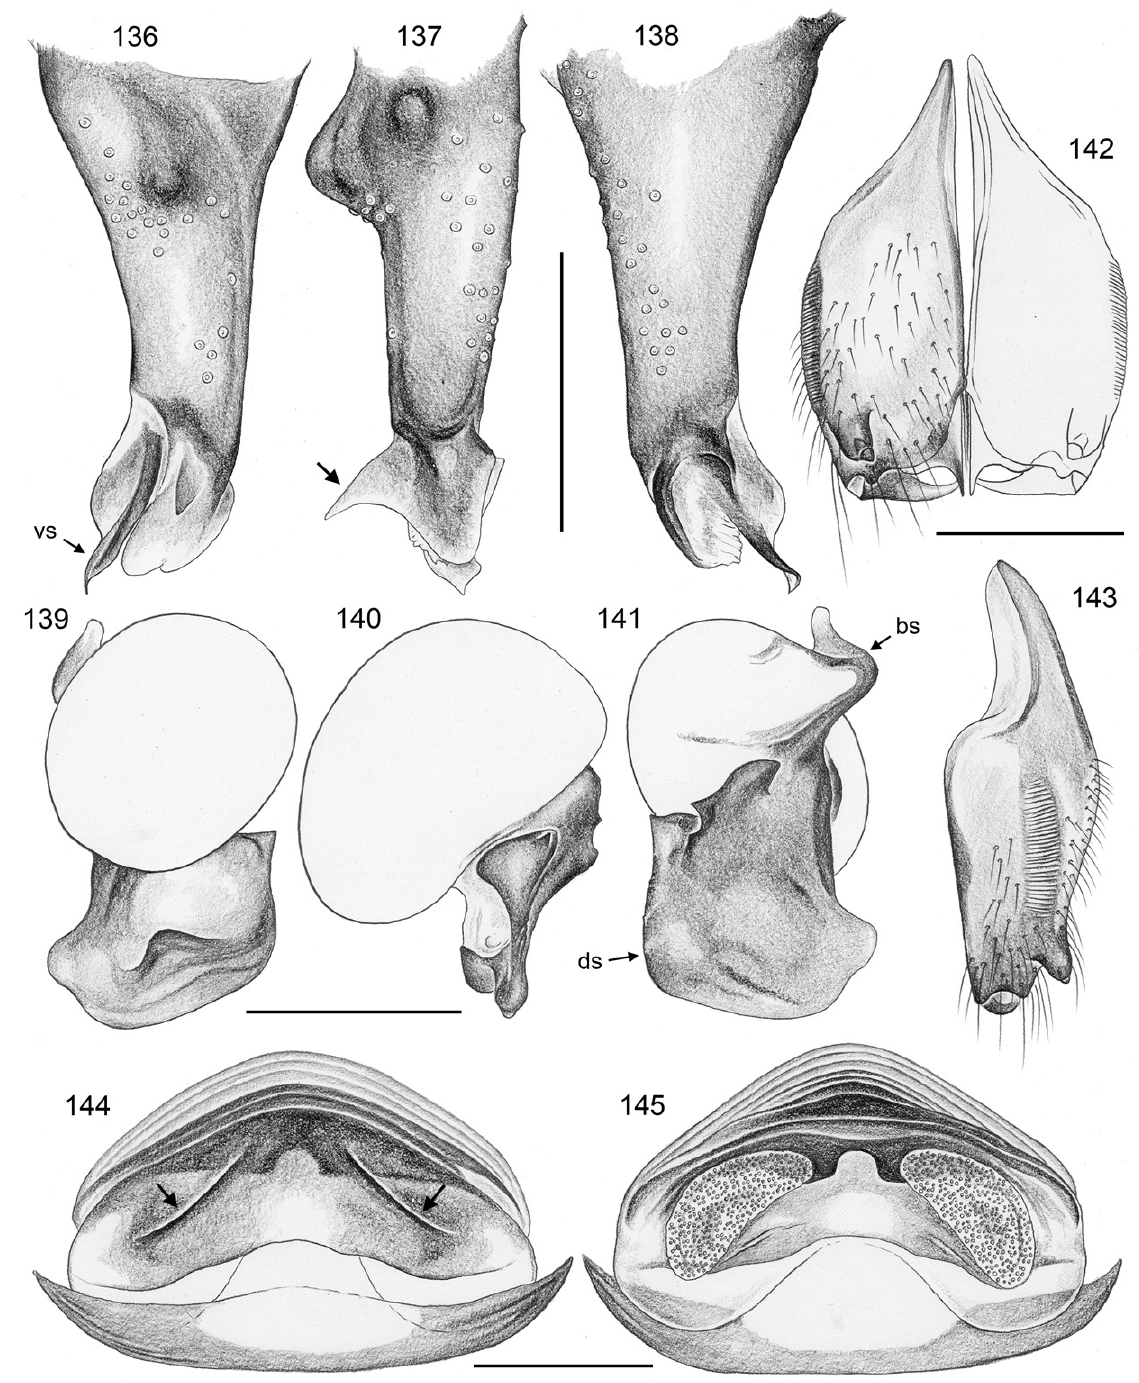
Figs 136–145. Holocnemus hispanicus Wiehle, 1933; male from Spain, Cáceres, Conquista de la Sierra (CRB), female from Spain, Málaga, Ronda (CRB). 136–138 . Left procursus, prolateral, dorsal, and retrolateral views; arrow: prolateral transparent process. 139–141 . Left genital bulb, prolateral, dorsal, and retrolateral views. 142–143 . Male chelicerae, frontal and lateral views. 144–145 . Cleared female genitalia, ventral and dorsal views; arrows: pockets. Abbreviations: bs = basal sclerite; ds = distal sclerite; vs = ventral sclerite. Scale bars = 0.3